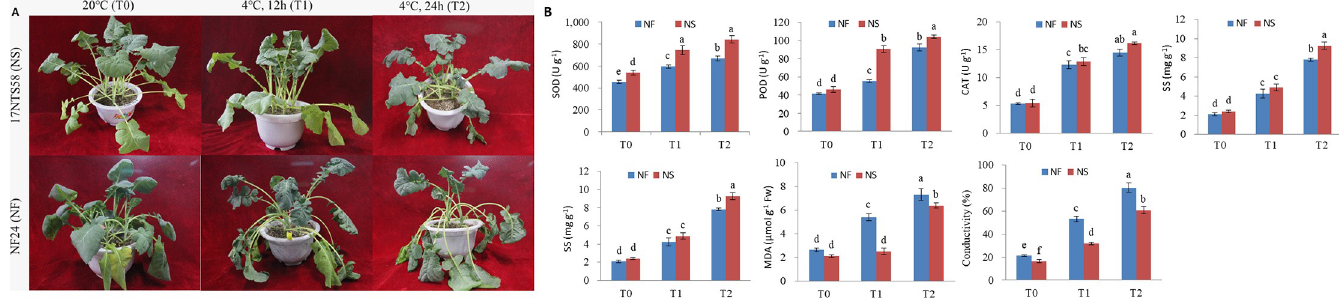
Fig 1. Morphological characteristics and physiological indexes of winter rapeseed seedling under cold stress and room tempareture condition. (A) Morphological characteristics of NS and NF; (B) Physiological indexes of NS and NF under cold stress and room tempareture. Error bars denote standard error of the mean. Significant differences between various treatments at p � 0.05 are denoted by a various